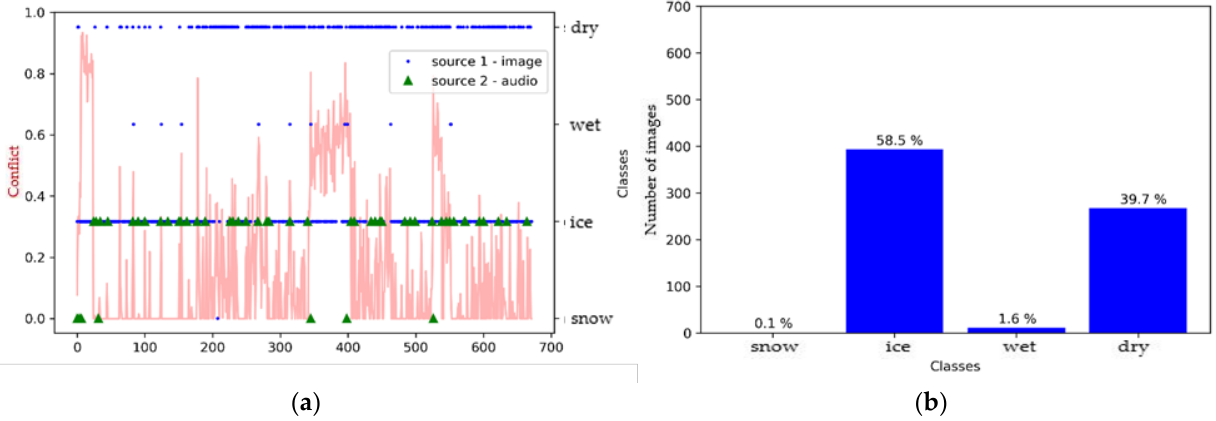
Figure 7. Environment #1. ( a ) Classification of sources with SqueezeNet (video) and M5 (audio) prior to fusion, together with conflict analysis; ( b ) histogram prior to image fusion.